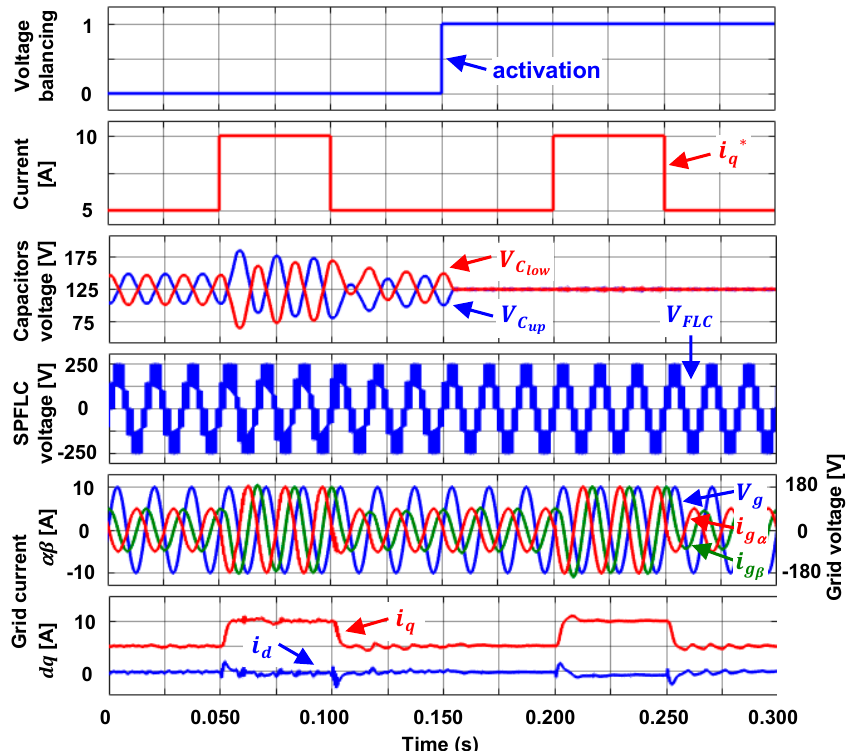
Figure 7. Performance of the voltage balancing strategy and the vector control for the proposed grid-tied SPFLC during a step-change in the 𝑞 axis grid current.